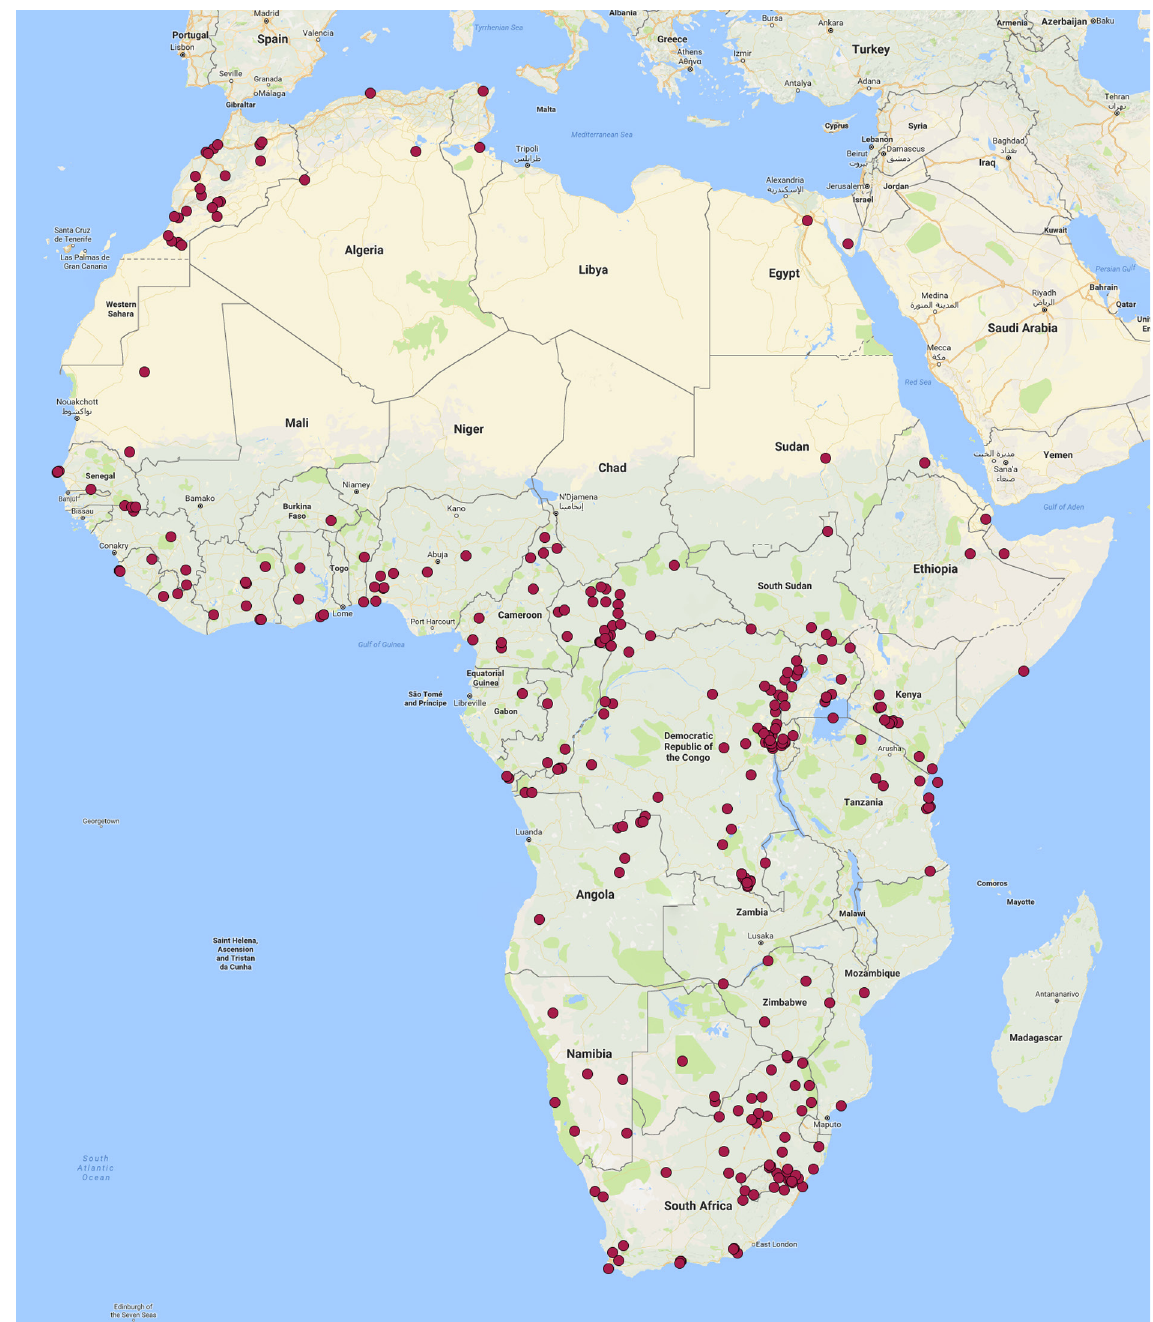
Fig. 5. Map of collection